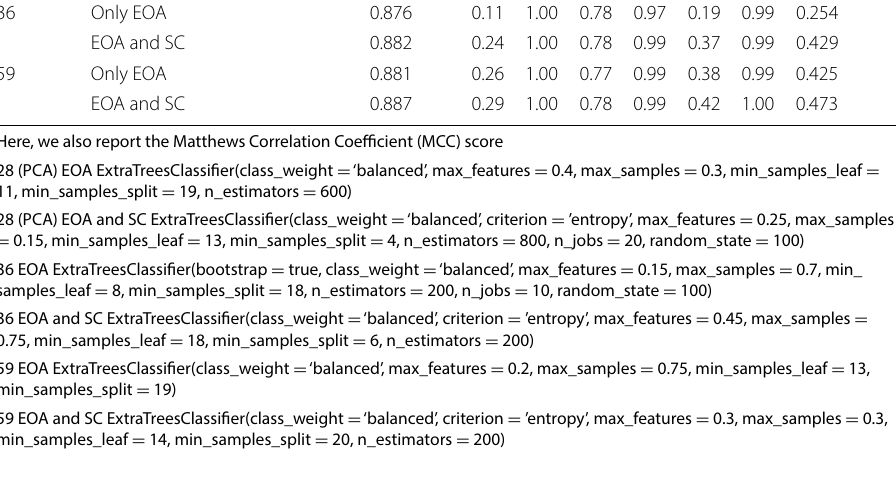
Here, we also report the Matthews Correlation Coefficient (MCC)